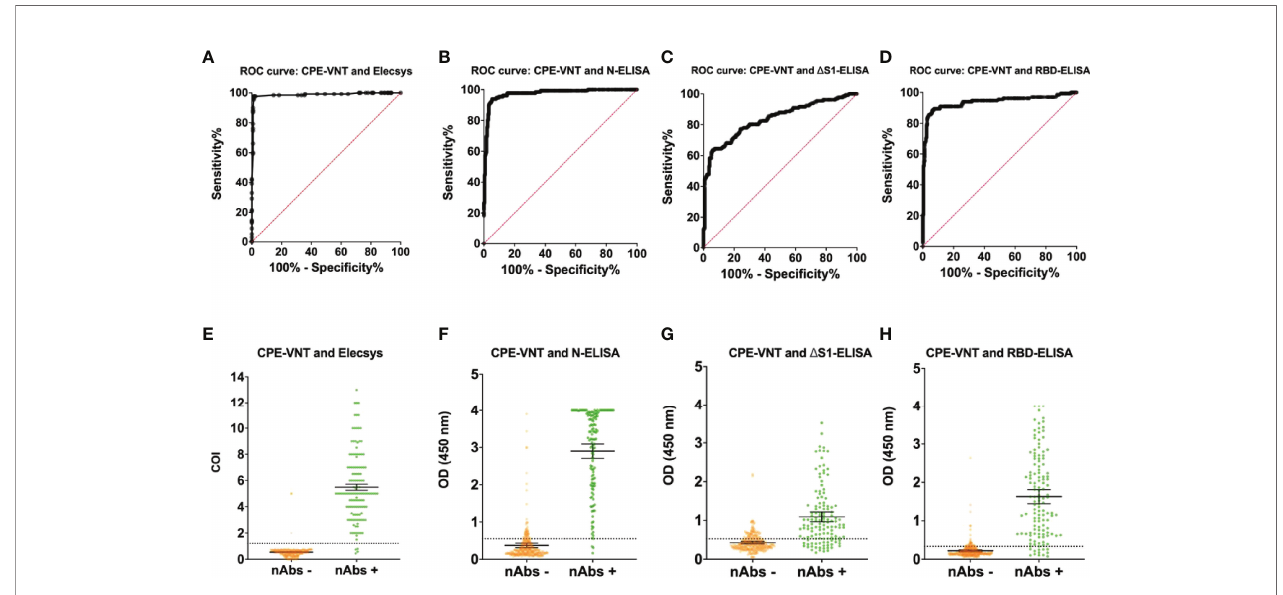
FIGURE 1 | ROC curve analysis after CPE-VNT validation and data distribution of Elecsys ® Anti-SARS-CoV-2 Immunoassay and in house ELISA assays. The tests performances were calculated individually after CPE-VNT validation of the tested samples. All the performance analyses were obtained through ROC curves (A – D) and samples ’ individual data (E – H) for the Elecsys ® Anti-SARS-CoV-2 Immunoassay (A , E) , N-ELISA assay (B , F) , D S1-ELISA assay (C , G) and RBD-ELISA assay (D , H) , respectively. Error bars and dashed lines represent 95% con fi dence interval (CI) and assay cut-off, respectively.